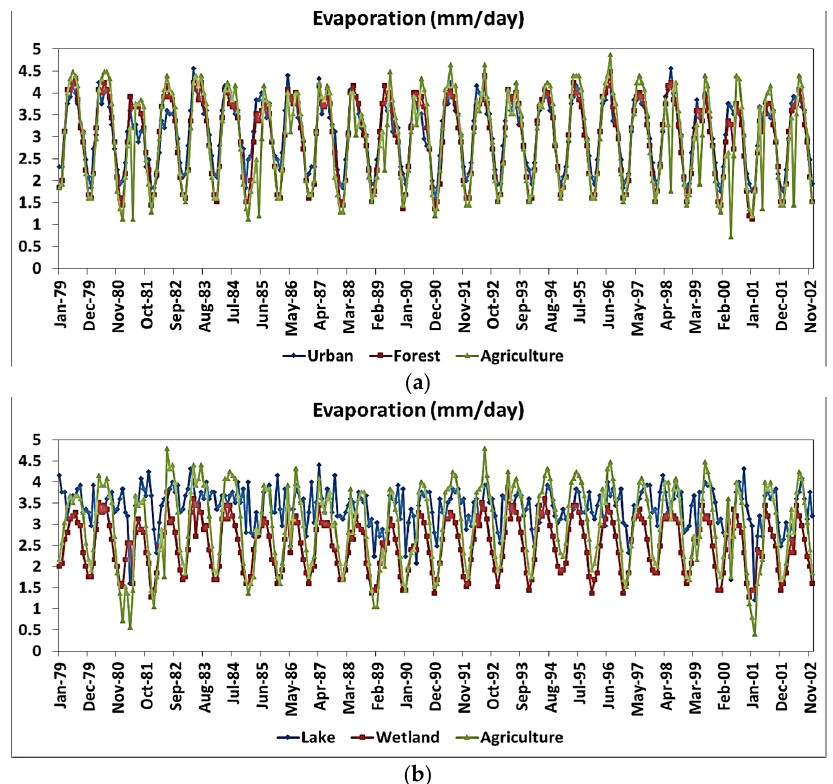
Figure 6. ( a ) Time series for monthly evaporation patterns for Northeast Florida; ( b ) Time series for monthly evaporation patterns for South Florida.